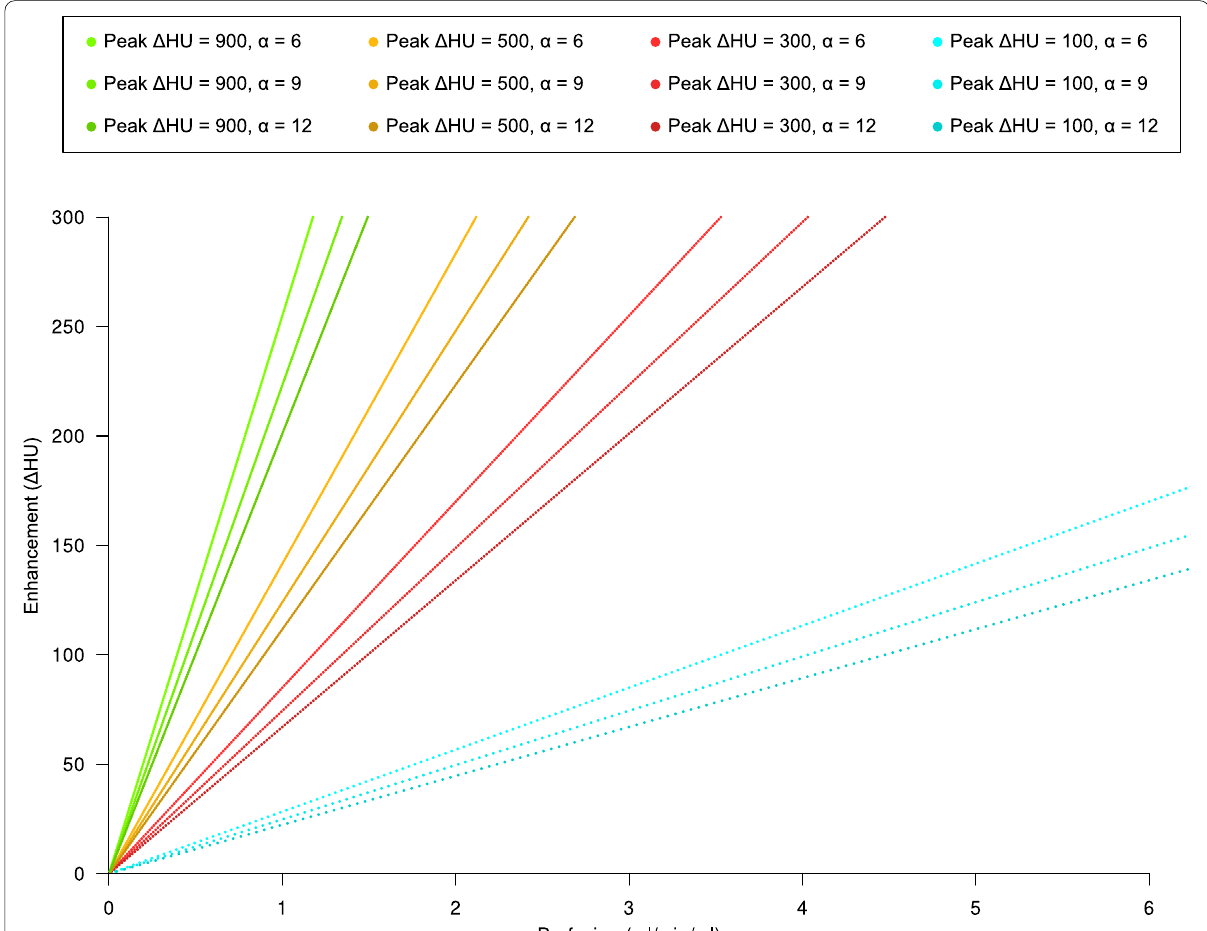
Fig. 4 Relationship between peak arterial phase tissue enhancement (peak ΔHU) and organ perfusion (mL/s/mL) in a parenchymatous organ with a t max of approximately 35 s for different peak feeding vessel enhancements and α parameters. To estimate peak arterial phase tissue enhancement, we assumed that contrast medium, injected in a peripheral vein or in a central venous catheter, is diluted by the right and left heart into the whole cardiac output before entering arterial circulation. Assuming a negligible total volume change due to contrast agent injection, if we inject 1.25 mL/kg of a iodinated contrast agent with a 350 mgI/mL concentration at 3.2 mL/s flow rate in a 80 kg man with an average cardiac output of 5000 mL/min (approximately 83 mL/s) and we acquire a CT scan at 120 kVp (with a constant of 26.18 for ΔHU calculation), peak ΔHU will then be 3.2 × 350 ×